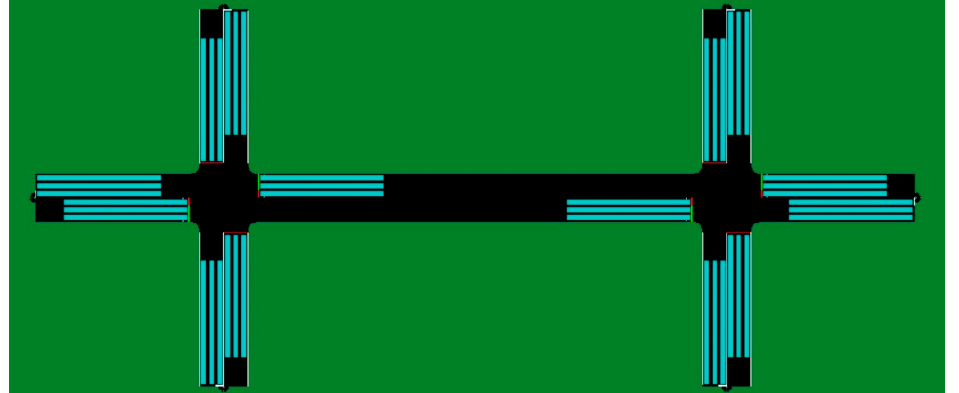
Figure 6. A traffic grid with two synthetic intersections.